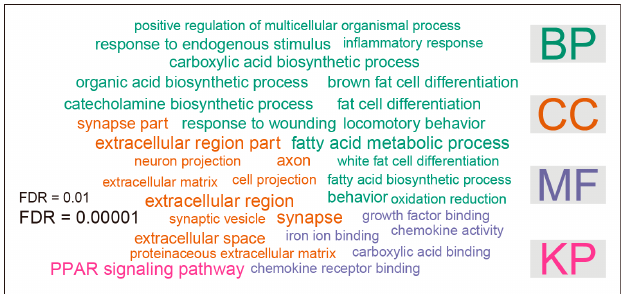
Figure 2. Gene ontology (GO) and pathway analysis of differentially expressed genes. The enrichment test was performed by using the DAVID tool. The significance cutoff for false discovery rate (FDR) was set at 0.01. The font sizes in the word cloud were proportional to -log10 of FDR for each enriched GO terms. GO terms were arranged in three categories: biological process (BP), cellular component (CC), and molecular function (MF), respectively. Pathway analysis was based on KEGG pathway (KP)